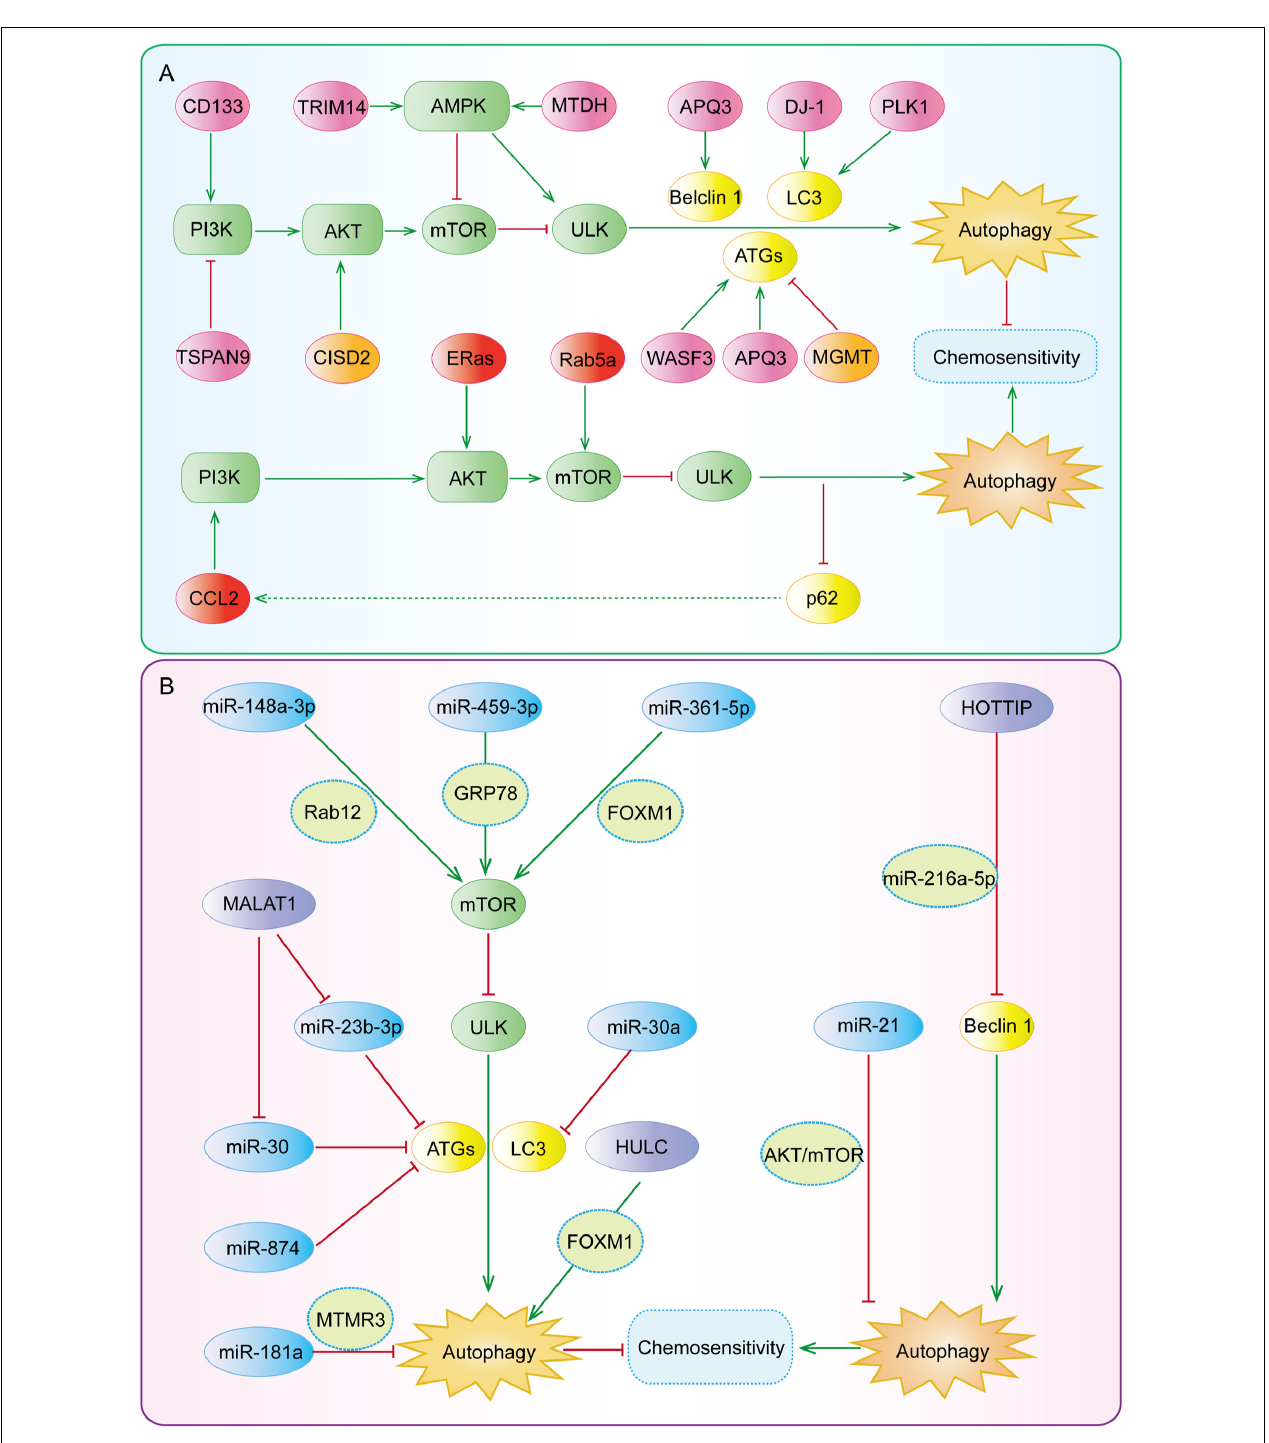
FIGURE 5 | The key regulatory nodes in autophagy-mediated gastric cancer chemoresistance. Various regulatory nodes, including several (A) proteins and (B) ncRNAs, are involved in the regulation of autophagy, thereby enhancing or reversing the chemotherapy resistance of gastric cancer.